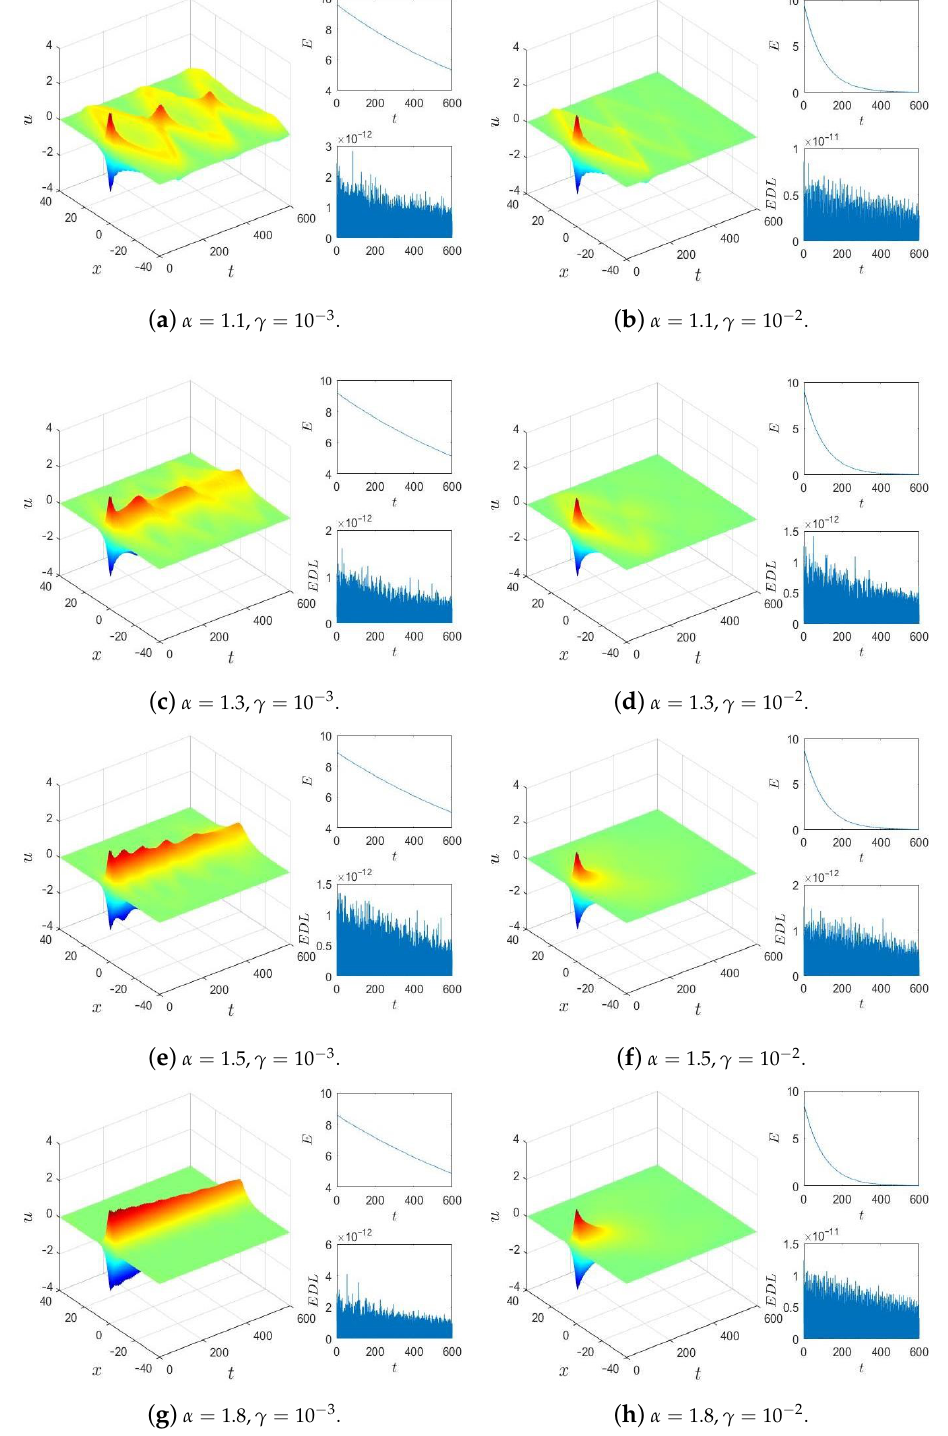
Figure 2. Surfaces of the numerical solutions, discrete energy E n , and the discrete dissipation- preserving law EDL n for different α and γ with h = 1/4 and τ =